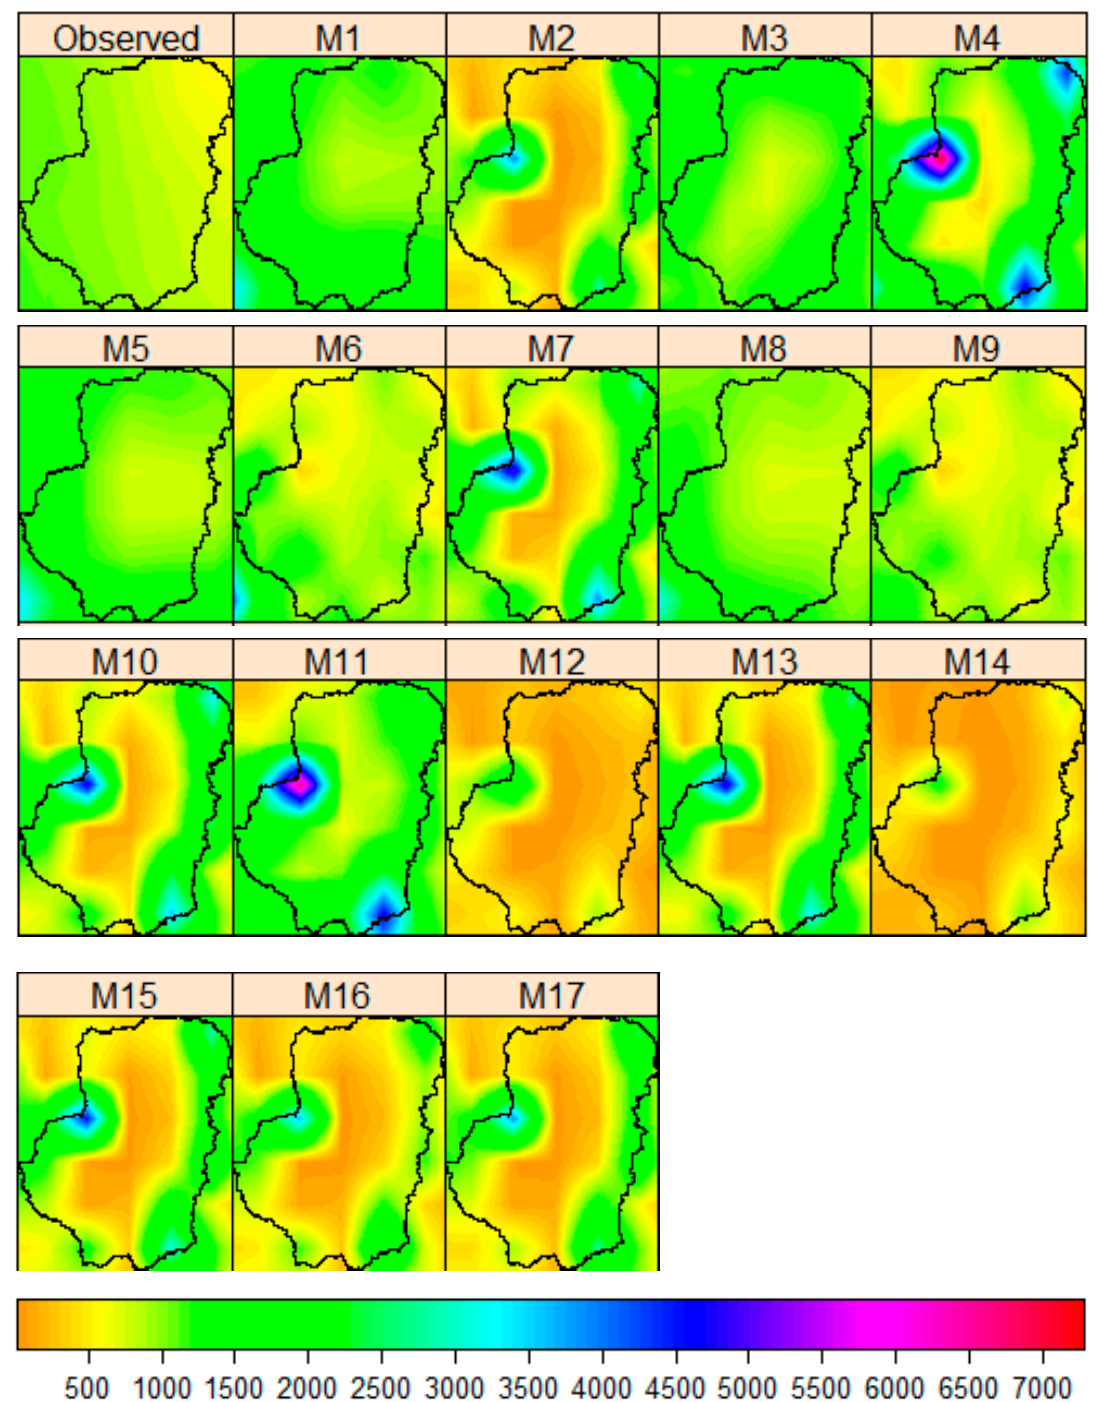
Figure 5. Spatial distribution of mean annual rainfall (in mm) from observed data, and individual climate models over the period of 1986–2005.